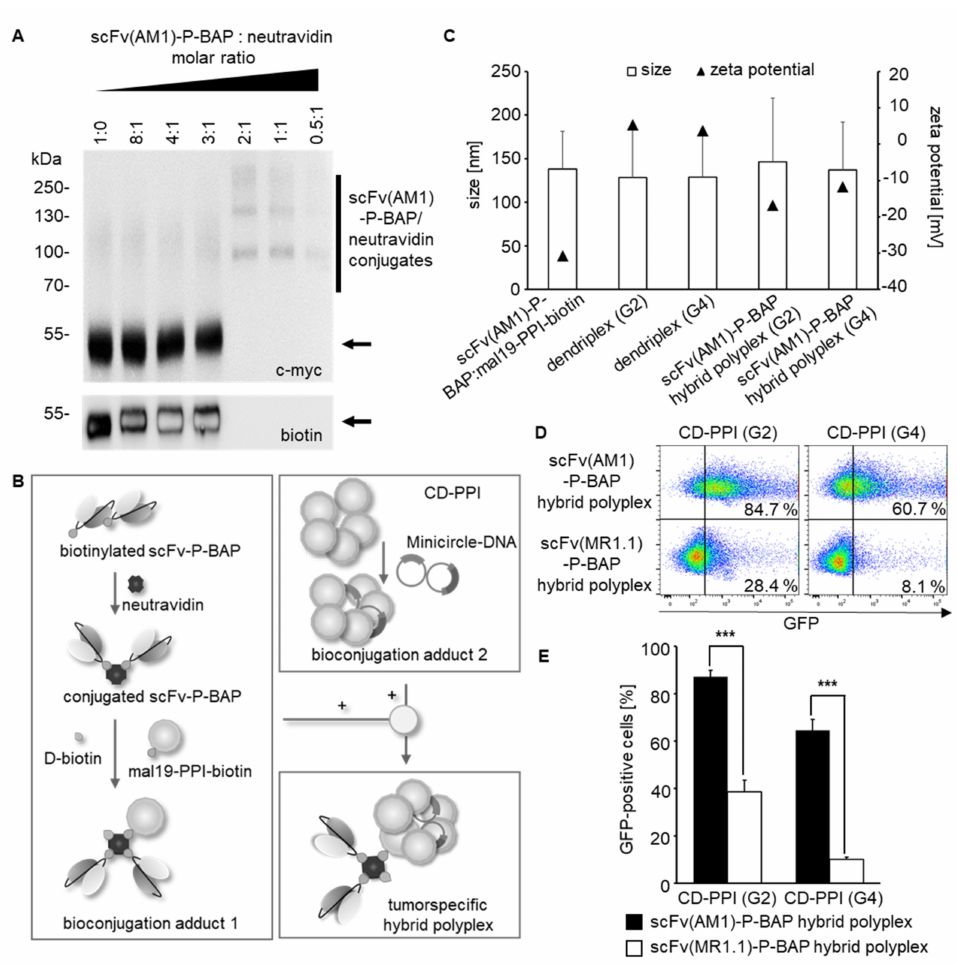
Figure 3. Assembly of scFv(AM1)-P-BAP-guided hybrid polyplexes. ( A ): Titration for the bind- ing of scFv(AM1)-P-BAP to neutravidin with increasing molar ratios. Western Blot analysis showing scFv(AM1)-P-BAP/neutravidin complex formation or unbound scFv(AM1)-P-BAP us- ing anti-c-myc and anti-biotin antibodies. Uncropped Western Blots can be found at Figure S5. ( B ): Schematic representation of the successive conjugation of scFv(AM1)-P-BAP-guided hybrid polyplexes. ( C ): Assessment of particle sizes and zeta potential of scFv(AM1)-P-BAP-guided hy- brid polyplexes. ( D ): Representative dot plot analysis of 293T PSCA cells, transfected with MC-GFP using scFv(AM1)-P-BAP-guided hybrid polyplexes in comparison to PSCA-unspecific scFv(MR1.1)- P-BAP-hybrid polyplexes. ( E ): Transfection efficiency of scFv(AM1)-P-BAP-guided hybrid polyplexes in comparison to PSCA-unspecific scFv(MR1.1)-P-BAP-hybrid polyplexes. ( n = 3, mean ± SD). *** p <